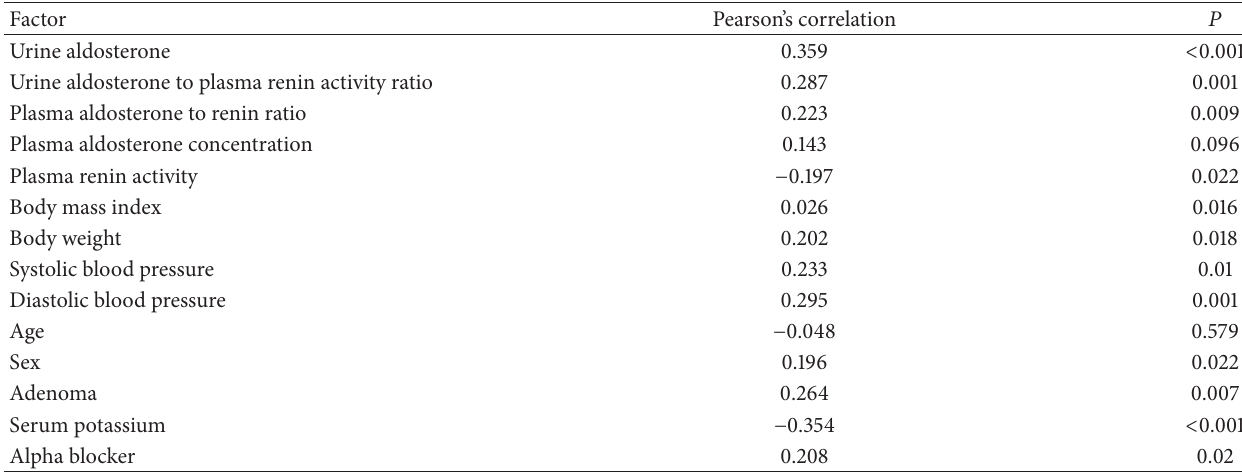
Table 3: Factors associated with LVMI in groups 1, 2, and 3 patients.